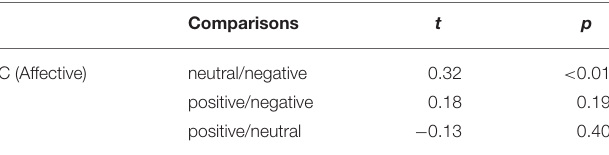
TABLE 4 | t / p -values for accuracy, comparing middle term affective conditions (Experiment